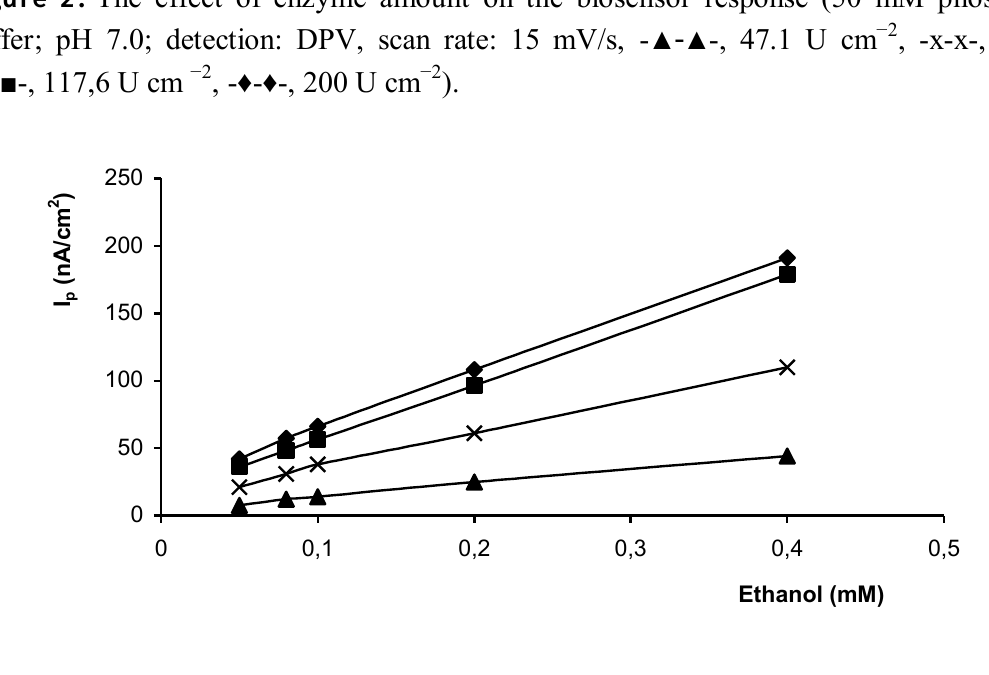
Figure 2. The effect of enzyme amount on the biosensor response (50 mM phosphate buffer; pH 7.0; detection: DPV, scan rate: 15 mV/s, - ▲ - ▲ -, 47.1 U cm −2 , -x-x-, 70,6, -■-■-, 117,6 U cm −2 , -♦-♦-, 200 U cm −2